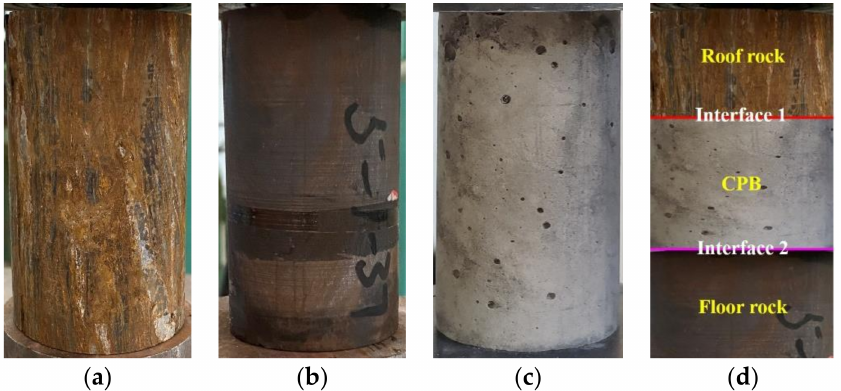
Figure 2. Test samples: ( a ) Roof rock sample; ( b ) Floor rock sample; ( c ) CPB sample; ( d ) RCF